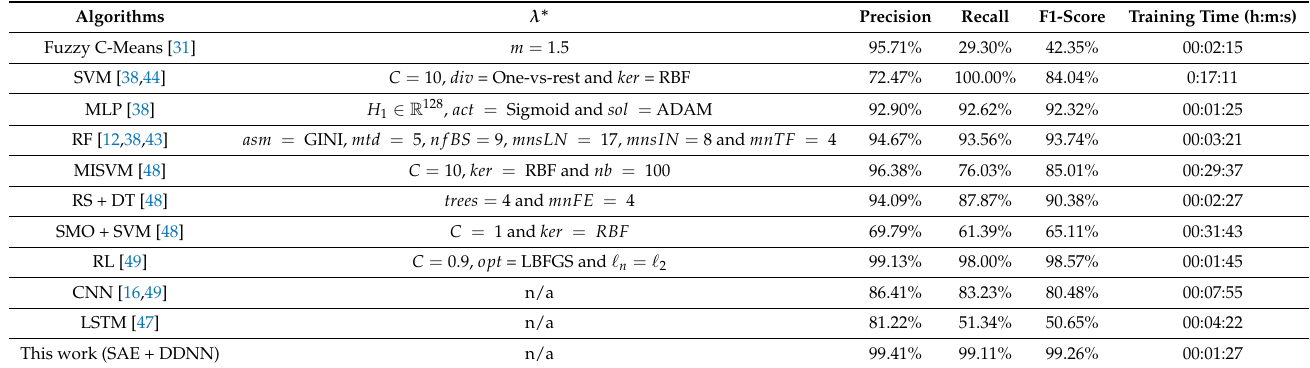
Table 10. Comparison of state-of-the-art results after applying the grid search method. A significant performance improvement can be noted in the proposed SAE + DDNN